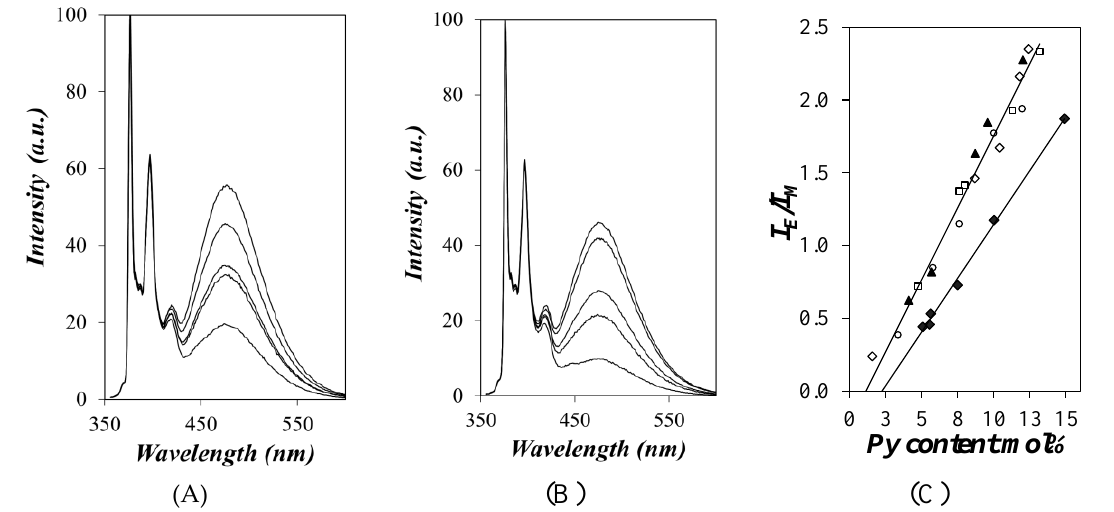
Figure 3. Fluorescence spectra of ( A ) Py-NAF57 and ( B ) Py-NAF8.3 in DMSO. From bottom to top, the pyrene content equals ( A ) 4.8, 7.6, 8.0, 11.3, and 13.2 mol% and ( B ) 3.4, 5.8, 7.6, 10.0, and 12.0 mol%. ( C ) Plot of I E / I M as a function of pyrene content for